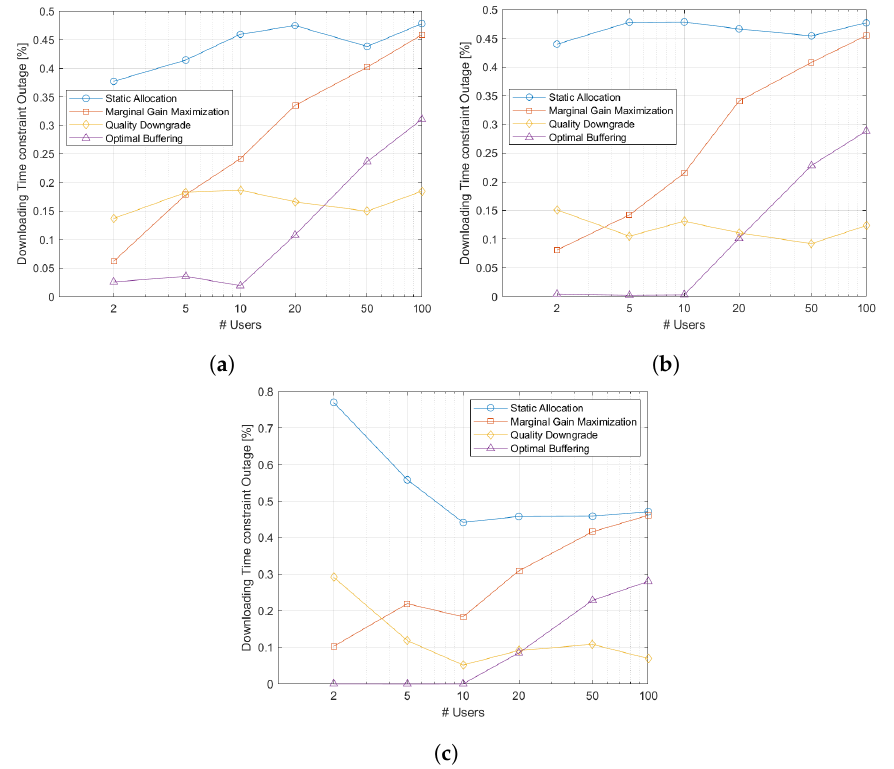
Figure 3. Outage probability with respect to downloading time constraints with a variable number of users. ( a ) Short videos. ( b ) Medium videos. ( c ) Long videos.